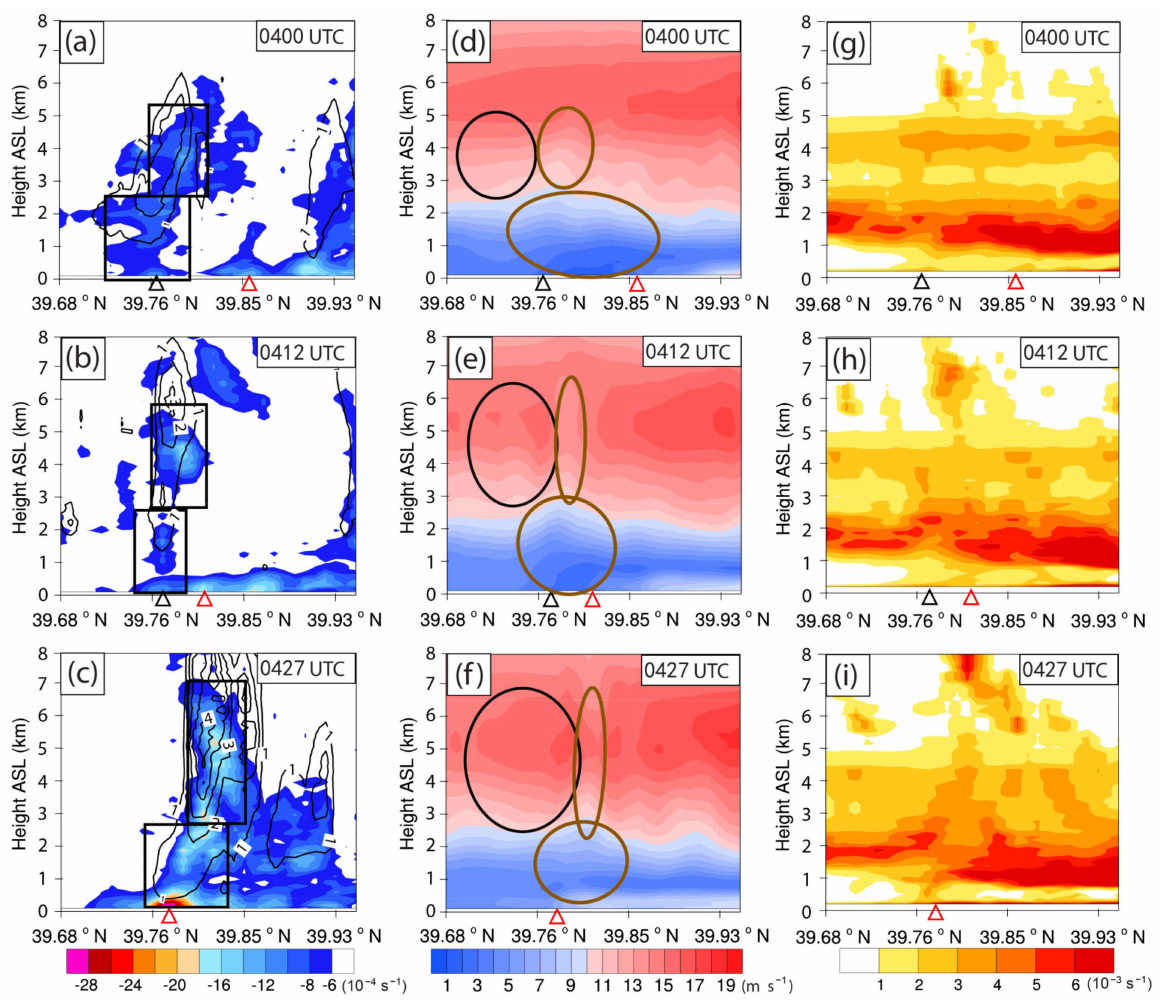
Figure 15. ( a – c ) Vertical cross section of the zonal-mean value of the horizontal divergence (shading, units: 10 − 3 s − 1 ) and vertical wind speed (black contours, units: m s − 1 ) in the red rectangle area in Figure 9b on 31 July 2010. The two black rectangles indicate the significant convergence regions in different levels; ( d – f ) are the same as ( a – c ) but for the horizontal wind velocity (HWV, shading, unit: m s − 1 ). The black ellipses indicate the near-upstream high-wind region, while the bold brown ellipses showed the weak-wind regions in different levels; ( g – i ) are the same as ( a – c ) but for the vertical shear of the horizontal wind (VSHW, shading, units: 10 − 3 s − 1 ). The black and red triangle symbols indicate the locations of the leading edges of the SBF and GF, respectively. The specific time is shown in the upper right corner of each